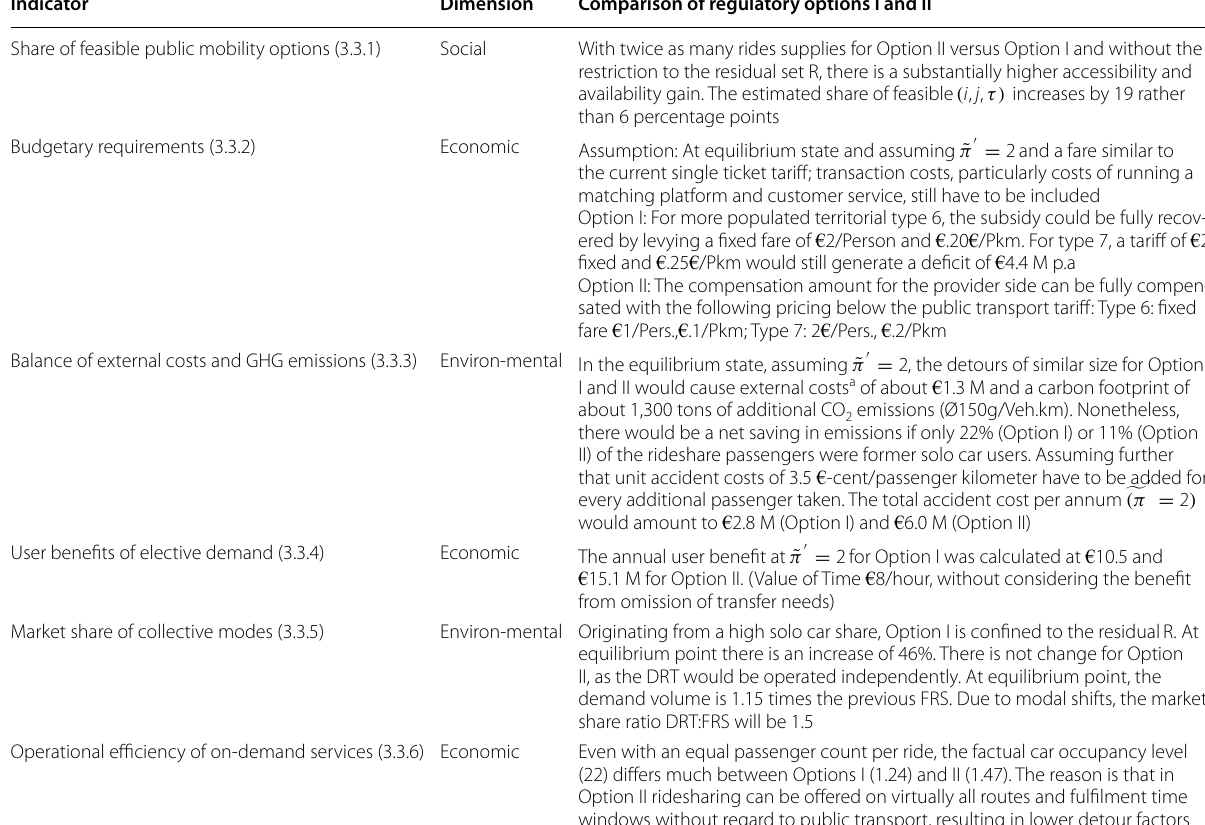
Table 5 Comparison regarding sustainable development indicators Indicator Dimension Comparison of regulatory options I and